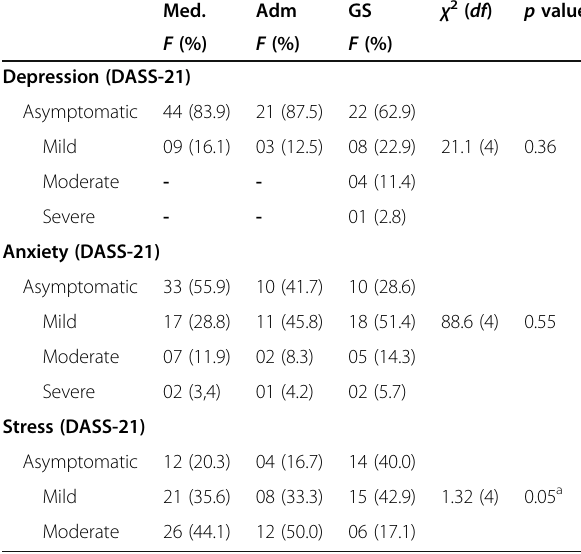
Table 2 Frequency of anxiety, depression, and stress symptoms in the 118